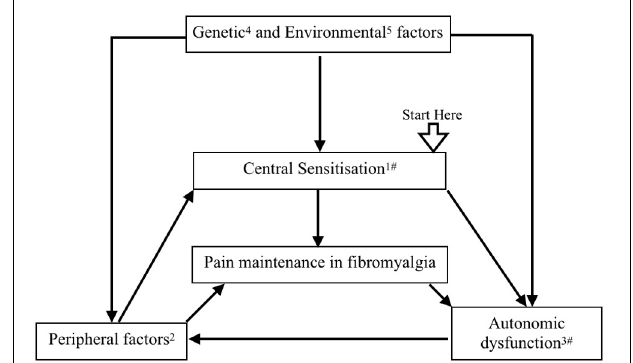
FIGURE 6 | A flow diagram proposing pathophysiology of fibromyalgia. Central sensitization has been proposed as one of the key pathophysiological mechanisms of fibromyalgia. Activation of peripheral pain receptor due to muscle pathology, regional ischemia due to autonomic dysfunction, and small fiber neuropathy cause pain generation and maintenance in muscles. Genetic and epigenetic modifications provide a background of peripheral factors and central sensitization. Stress, infection, vaccination, and environmental factors have been related with peripheral, central, and autonomic changes in fibromyalgia. Central sensitization and peripheral pain influence the autonomic system. All these factors make a positive feedback loop for pain maintenance in fibromyalgia. (1) Yunus (2008); Woolf (2011), Häuser et al. (2015); Harte et al. (2018). ( 2 ) Bengtsson (2002); Kulshreshtha et al. (2012), Harte et al. (2018). ( 3 ) Kulshreshtha et al. (2012); Meeus et al. (2013), Jay and Barkin (2015). (4) Diatchenko et al. (2013); D’Agnelli et al. (2019). (5) Buskila et al. (2008); Albrecht and Rice (2016). # Our study supports this mechanism.